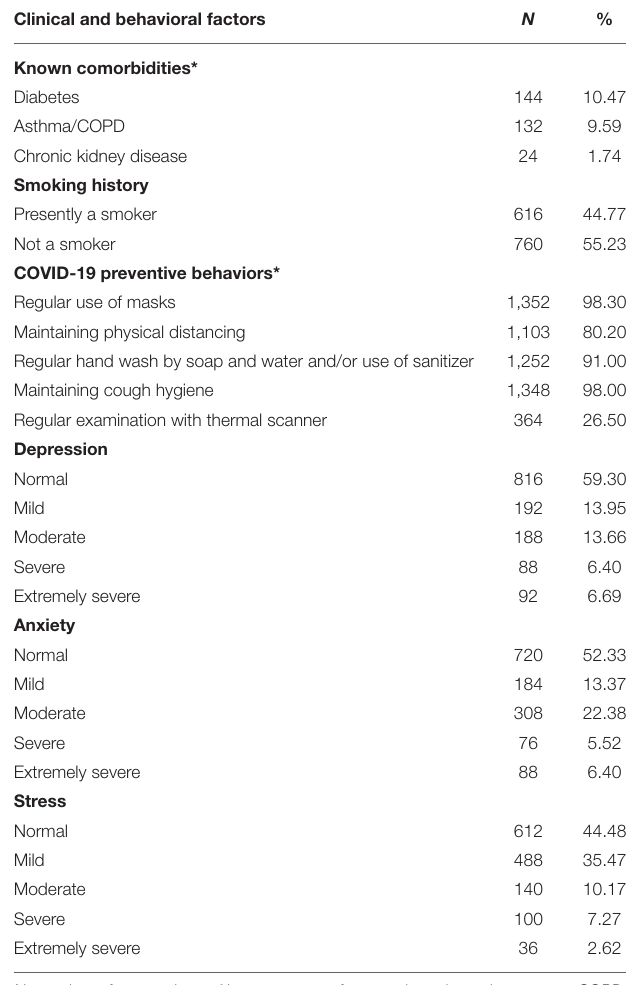
TABLE 1 | Background characteristics of the study participants. TABLE 2 | Clinical and behavioral profile of the